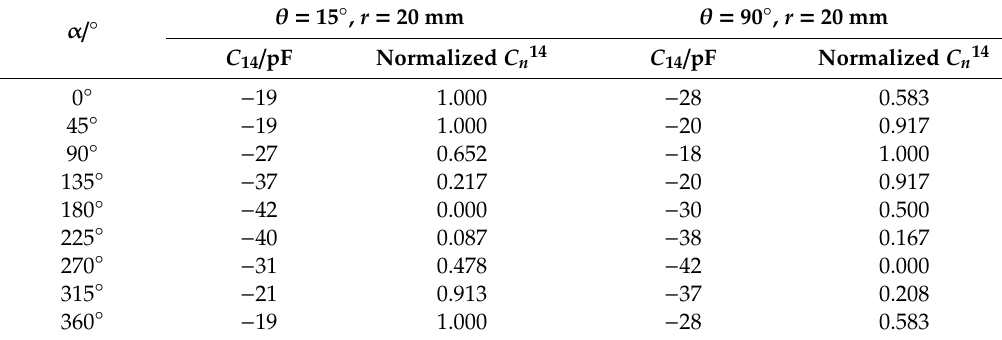
Table 3. The measured capacitance (fF) and normalized values between E1 and E4.